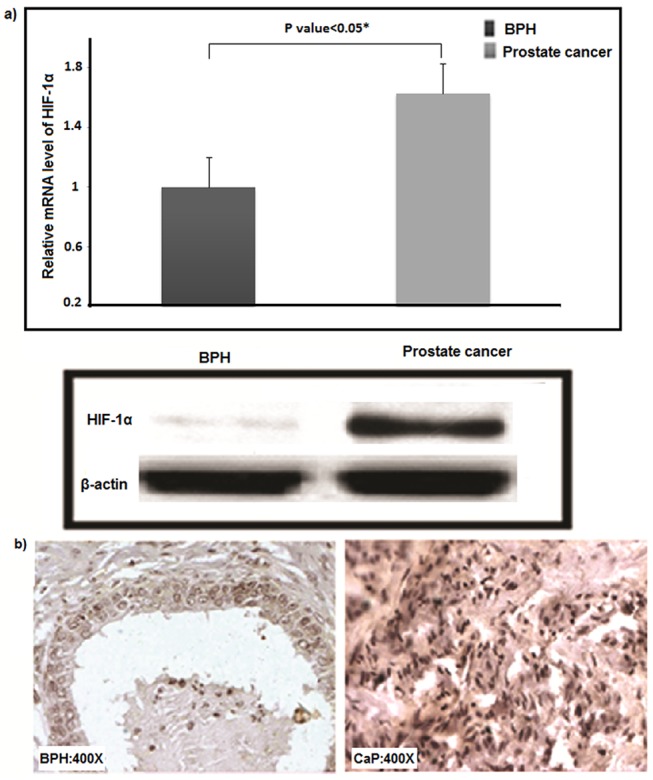
Expression of HIF-1α in malignant and benign prostatic tissues.(a) Upper panel: Bar diagram showing elevated expression of HIF-1α in prostate cancer compared to BPH patients at mRNA level. * indicates P <0.05. Lower panel: Representative result of Western blotting for HIF-1α in cancer and benign tissue of prostate where ACTB acted as endogenous control. (b) Photomicrograph of representative prostate archival specimens immune-stained with antibodies against HIF-1α at 400x magnification showing elevated expression of HIF-1α in prostate cancer tissues.